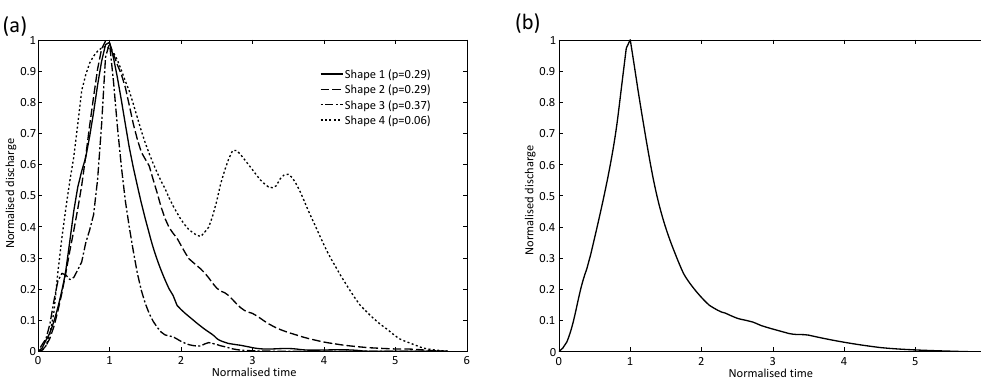
Figure 2. Characteristic normalised hydrograph shapes (a) with a certain probability of occurrence and (b) “mean” normalised hydrograph shape.